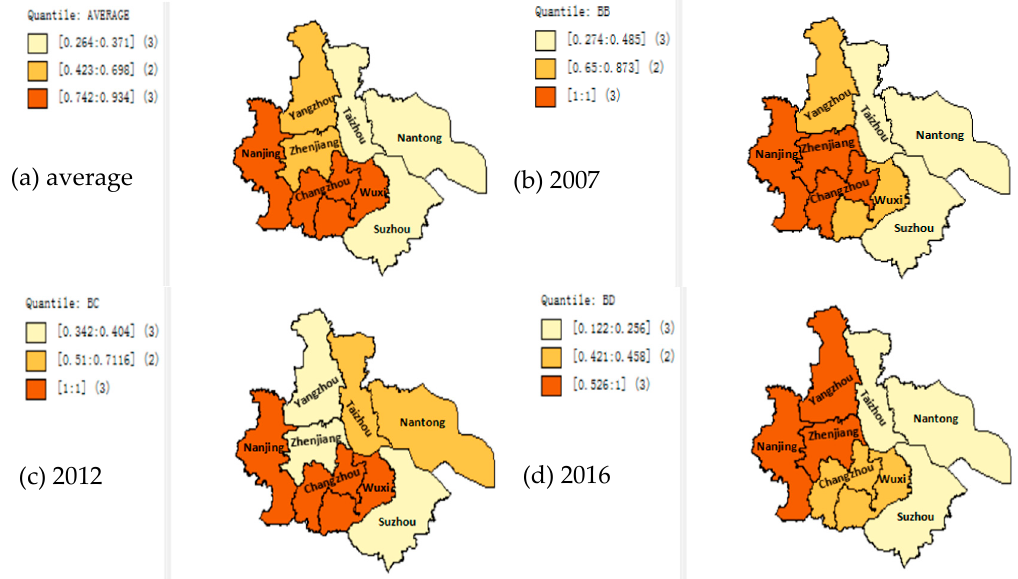
Figure 2. Distribution of EGE of the Yangtze River urban agglomeration. ( a ) Distribution of the average efficiency of the cities over 10 years; ( b ) Efficiency distribution of cities in 2007; ( c ) Efficiency distribution of cities in 2012; ( d ) Efficiency distribution of cities in 2016.